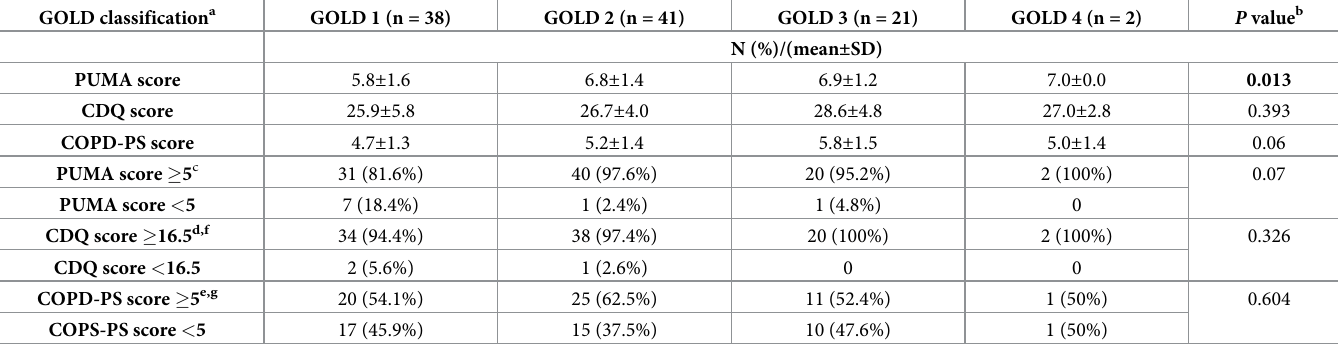
Table 2. GOLD classification according to airflow limitation severity in COPD. GOLD classification